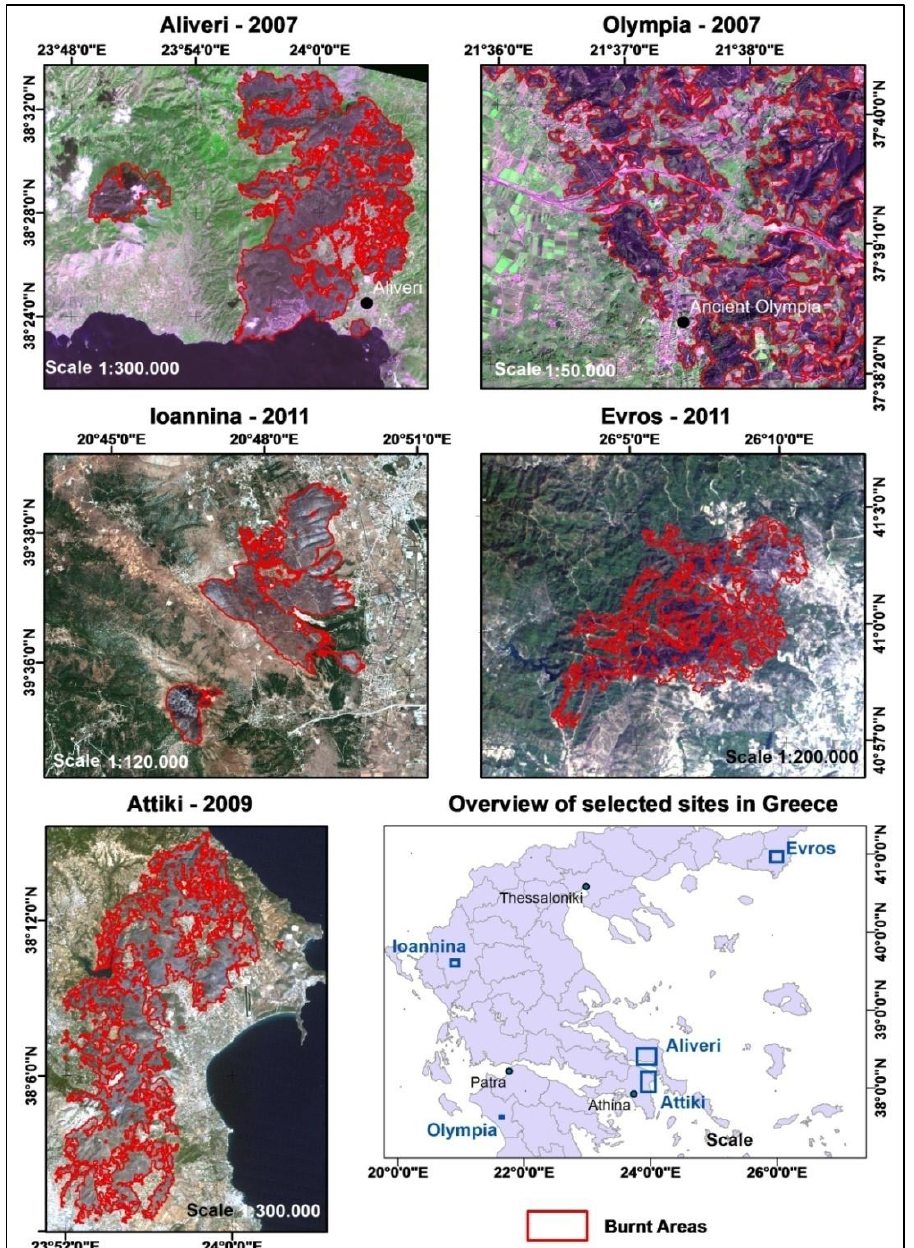
Figure 4. Burn Scar Maps (BSM) for the fire events at ( Upper Left ): Aliveri (SPOT-4 image, spatial resolution of 20 m); ( Upper Right ): Olympia archaeological site (FORMOSAT-2 image, spatial resolution 2 m); ( Middle Left ): periphery of Ioannina (WorldView-2 images, spatial resolution of 1.84 m); ( Middle Right ): Evros area (Landsat-5 TM, spatial resolution of 30 m) and ( Bottom Left ): NE Attica (Landsat-5 TM, spatial resolution of 30